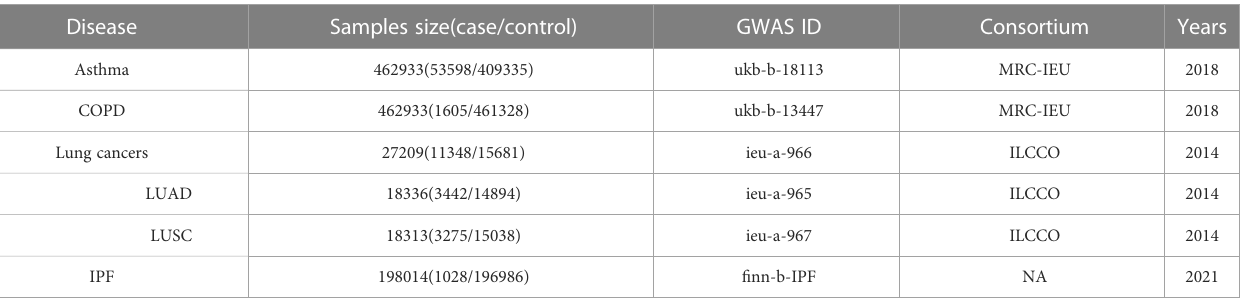
TABLE 1 The characteristics of GWAS